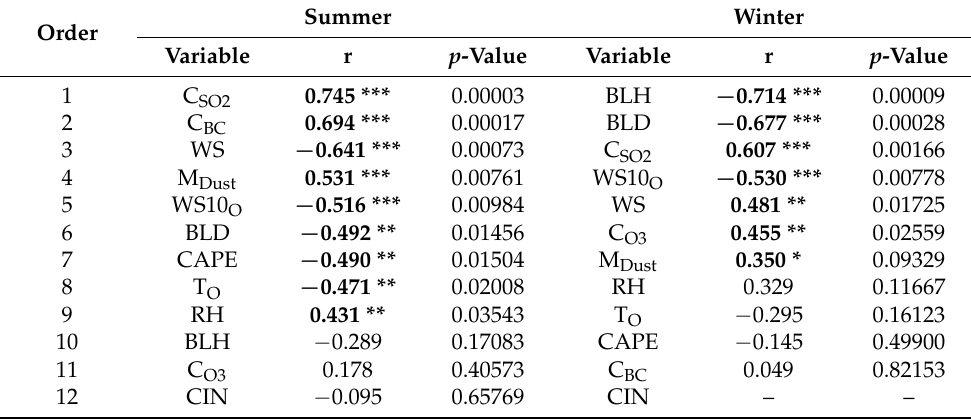
Table 2. The importance ranking of the factors affecting N CCN diurnal variation according to the absolute value of correlation r for summer and winter during 2005–2007. Results that pass the 90% confidence test are indicated in bold. The superscripts of ***, **, and * present the correlations passing the consistency test with the significance levels of 99%, 95% and 90%,